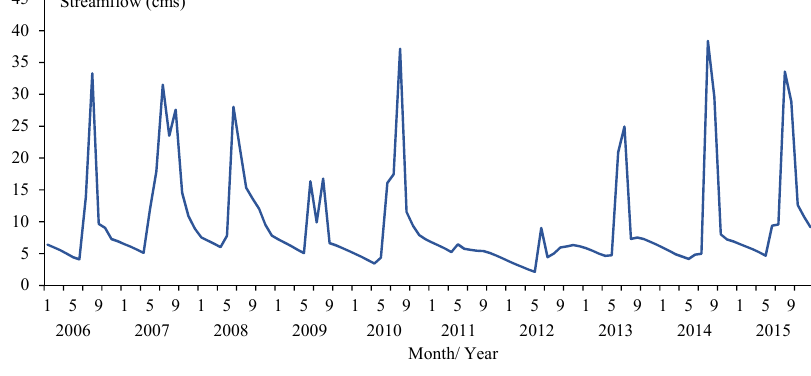
Figure 7. Simulated streamflow out of the upper reaches.